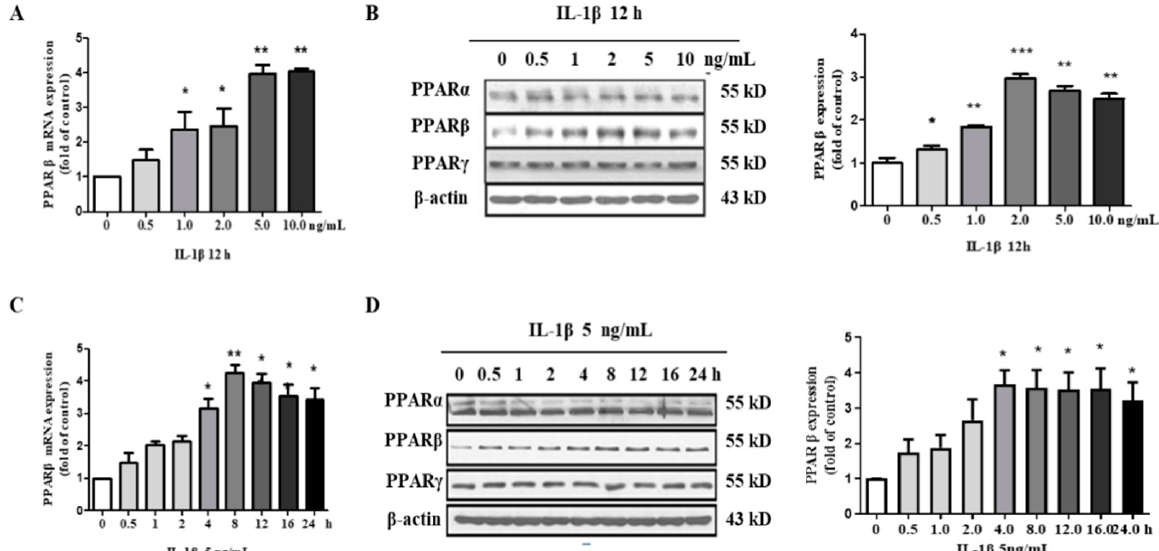
Figure 3. IL-1 β induces PPAR β / δ expression in human mesangial cells. ( A , B ) Real-time PCR and Western blot assays demonstrated that IL-1 β induced PPAR β / δ mRNA ( A ) and protein ( B ) expressions in a dose-dependent manner. The cells were treated with various concentrations of IL-1 β (0.5, 1, 2, 5, and 10 ng/mL) for 12 h. The protein expressions of PPAR α , PPAR β / δ , and PPAR γ were examined using Western blot. ( C , D ) Real-time PCR and Western blot assays demonstrated that IL-1 β induced PPAR β / δ mRNA ( C ) and protein ( D ) expressions in a time-dependent manner. The cells were incubated with IL-1 β (5 ng/mL) for the indicated time periods. * p < 0.05, ** p < 0.01, and *** p < 0.001 compared to the control (0 ng/mL or 0 h); n = 4. PPAR β : PPAR β / δ .